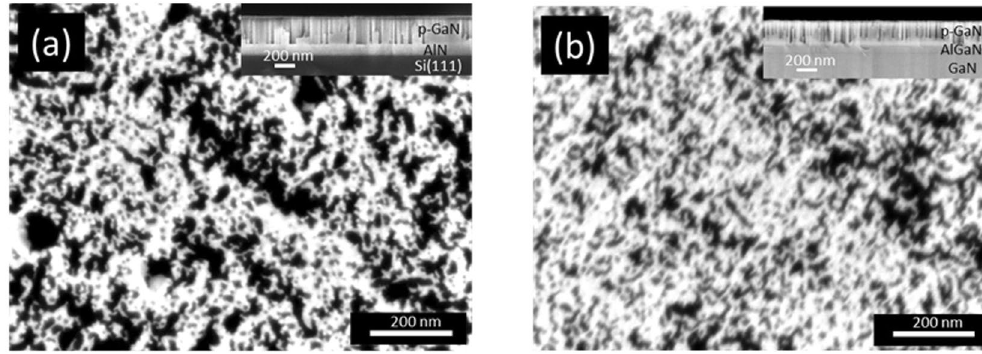
Figure 1. ( a ) Top-view scanning electron miscroscopy (SEM) image of porous GaN on AlN/Si(111). (b) Top- view SEM image of porous GaN on MOCVD-GaN template. Insets are cross-section view SEM